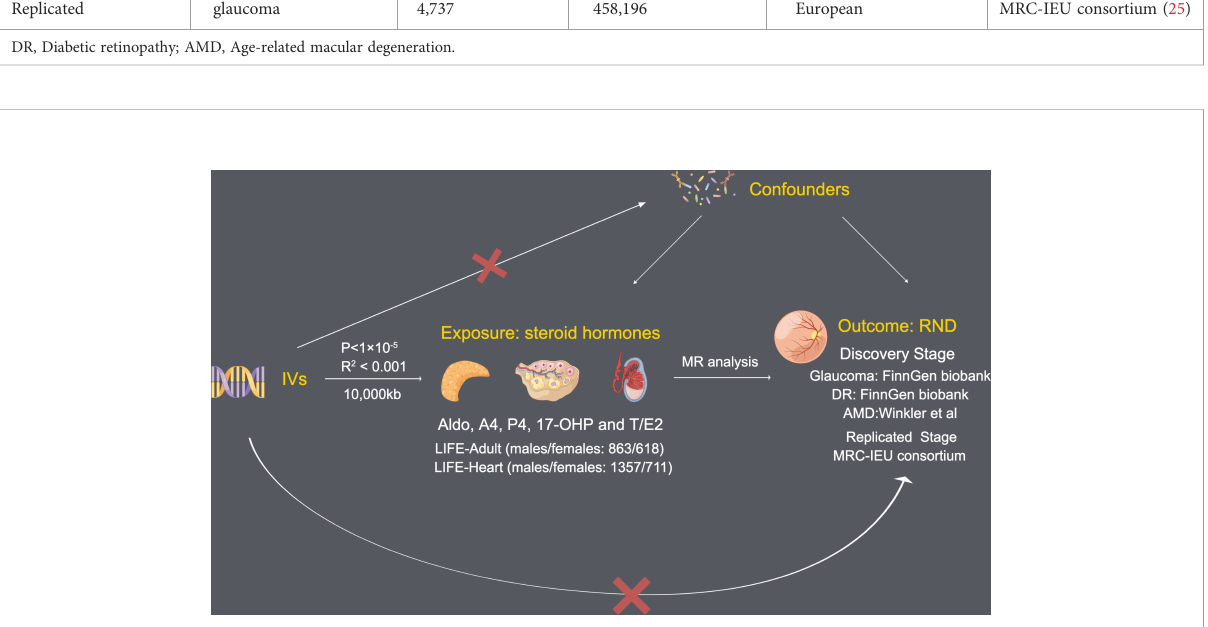
FIGURE 1 Assumptions of Mendelian randomization analysis between steroid hormone and RND.